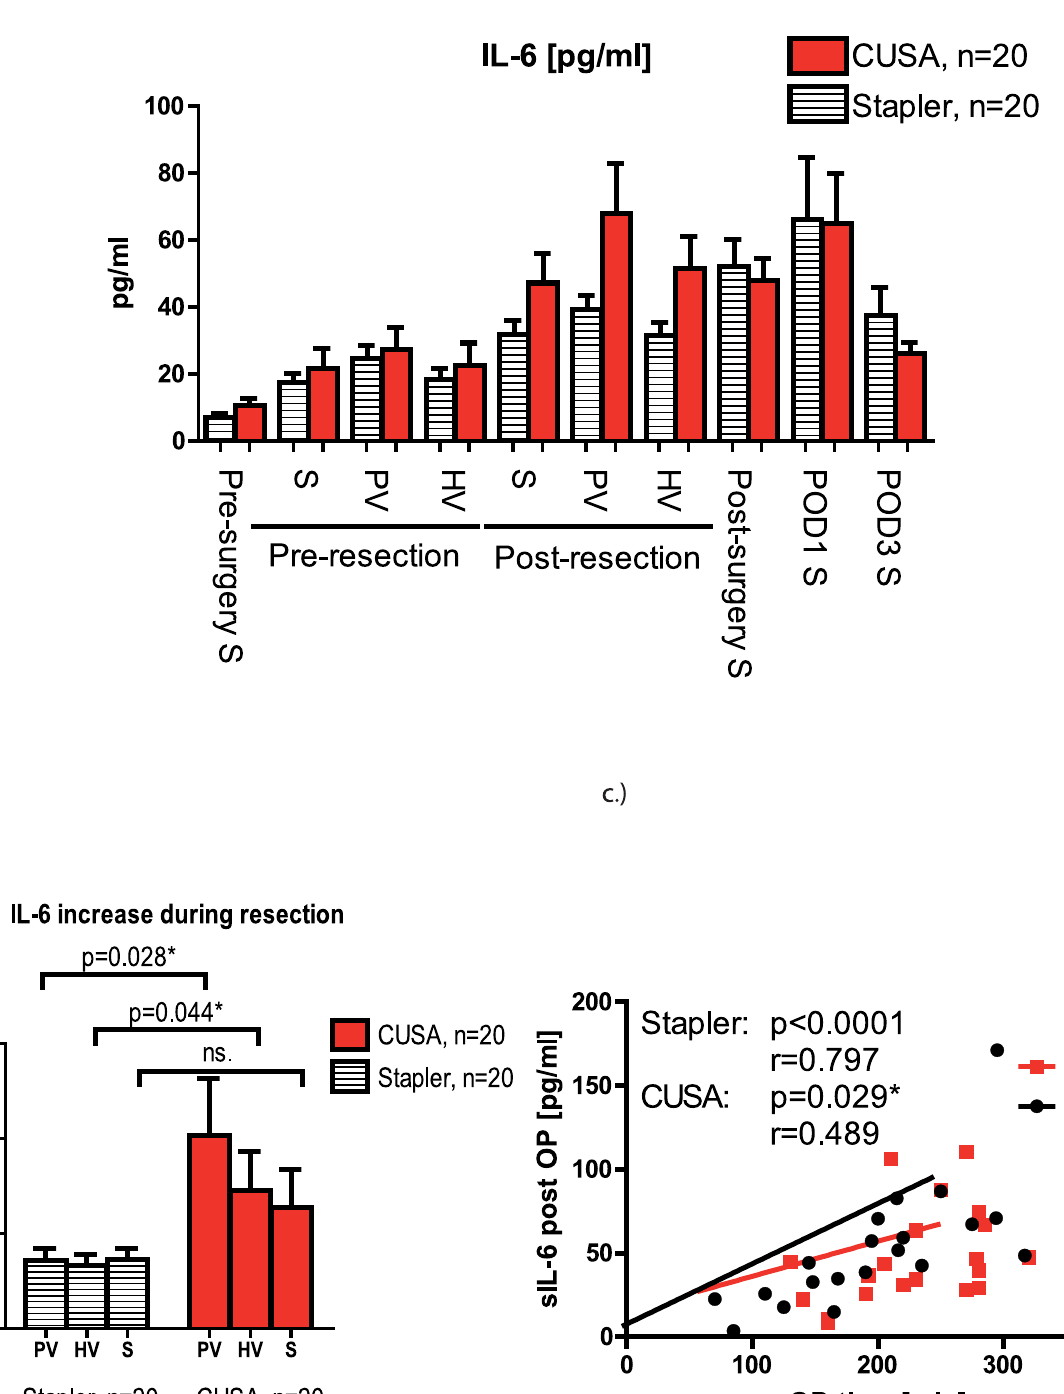
PLOS ONE | DOI:10.1371/journal.pone.0140314 October 9,